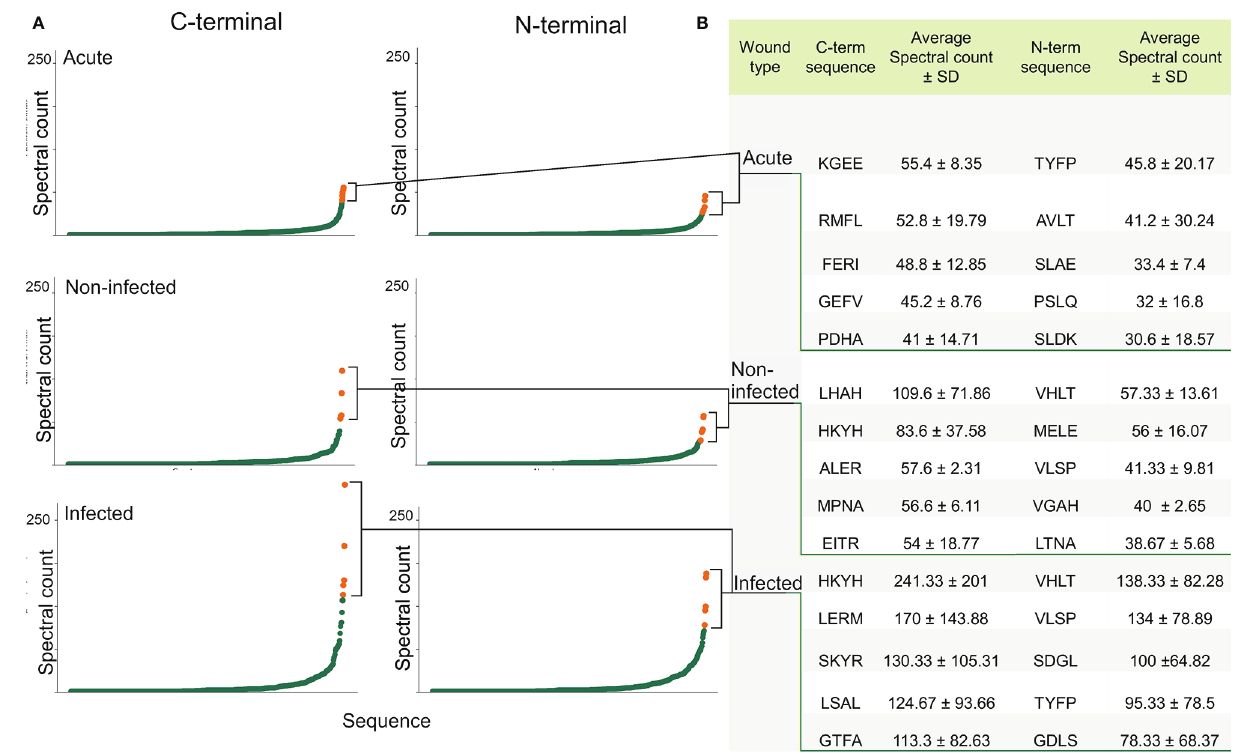
FIGURE 4 | Identi fi cation of the most abundant N- and C-terminals. (A) Scatter plots visualizing the distribution of the present N-terminals (the fi rst 4 amino acids) and C-terminals (the 4 last amino acids) by plotting the aggregated spectral count of the unique terminal sequences. A difference in curvature in the different groups can be seen. (B) Table showing the sequence and average spectral count of the most abundant terminals, which are highlighted in the scatter